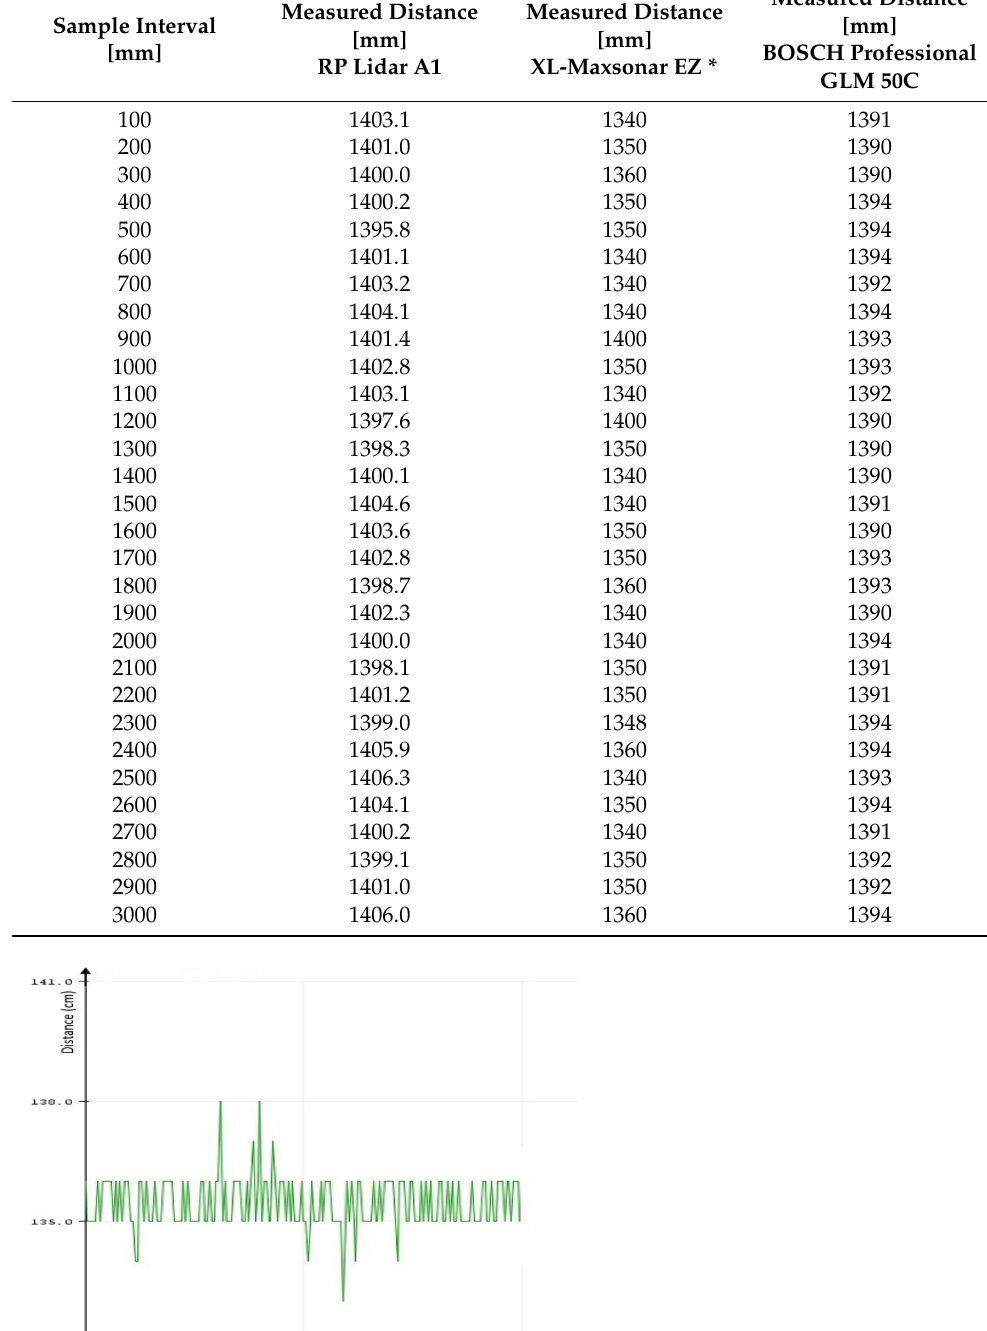
Table 1. Measurements on the subway rail (ambient temperature: 24 ◦ C).